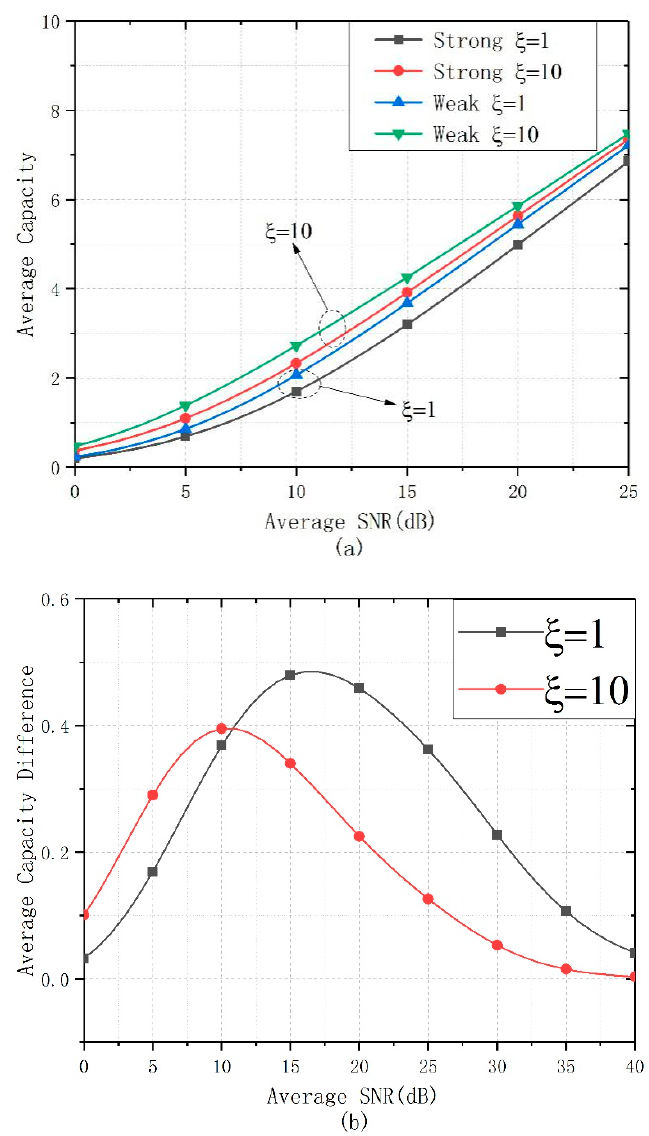
Figure 9. ( a ) Average capacity against average SNR per hop for different turbulence intensities and different pointing error parameters. ( b ) Average capacity difference between different pointing error parameters.